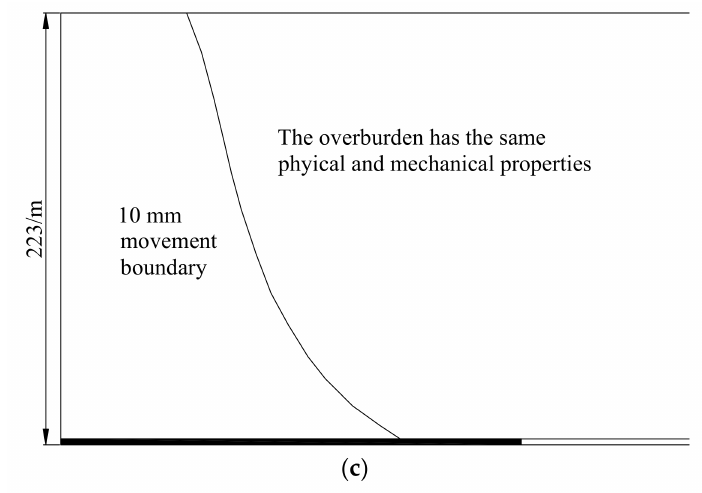
Figure 11. The 10 mm movement boundary of the overburden with and without KS. ( a ) The influence of elastic modulus of KS; ( b ) The influence of height of KS; ( c ) Movement boundary without KS in the